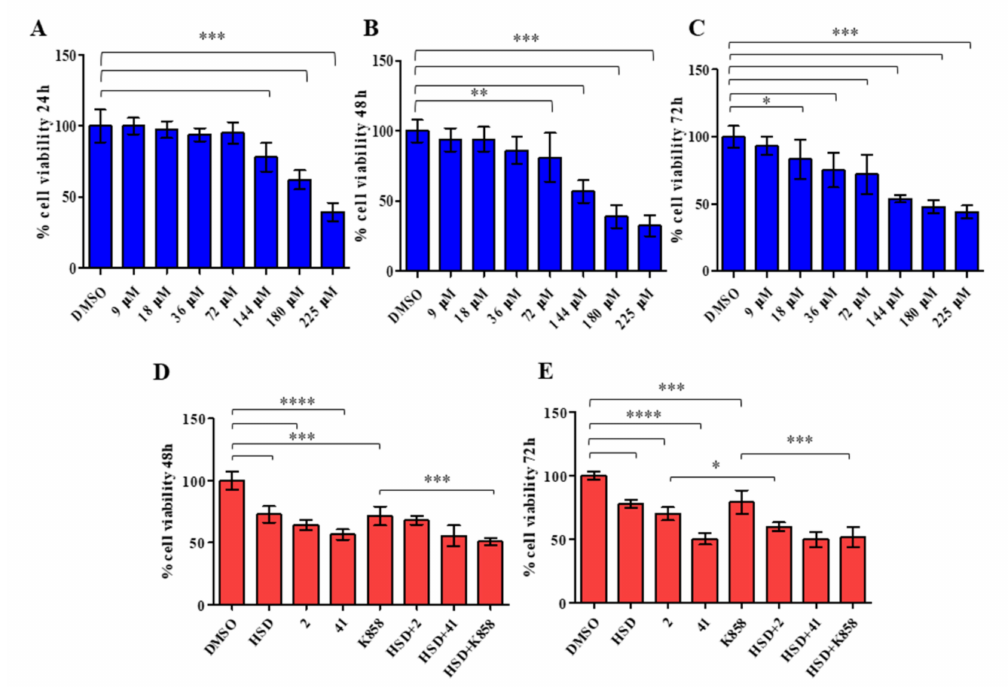
Figure 4. MTT test on AGS cell line treated with increasing doses of HSD (from 9 to 225 µ M) for 24, 48, and 72 h ( A – C , respectively). *** p < 0.0001; ** p < 0.001; * p < 0.01. MTT test on AGS cells treated with HSD (180 µ M), 2 (1 µ M), 41 (5 µ M), K858 (1 µ M), and a combination of HSD with each Eg5 inhibitor for 48 and 72 h ( D – E , respectively). **** p < 0.0005, *** 0.005 < p < 0.001, * p < 0.05. Metabolic activity was normalized to control cells treated with DMSO (0.5% as final concentration). DMSO: control vehicle. Data shown represent the mean ± SD of three independent